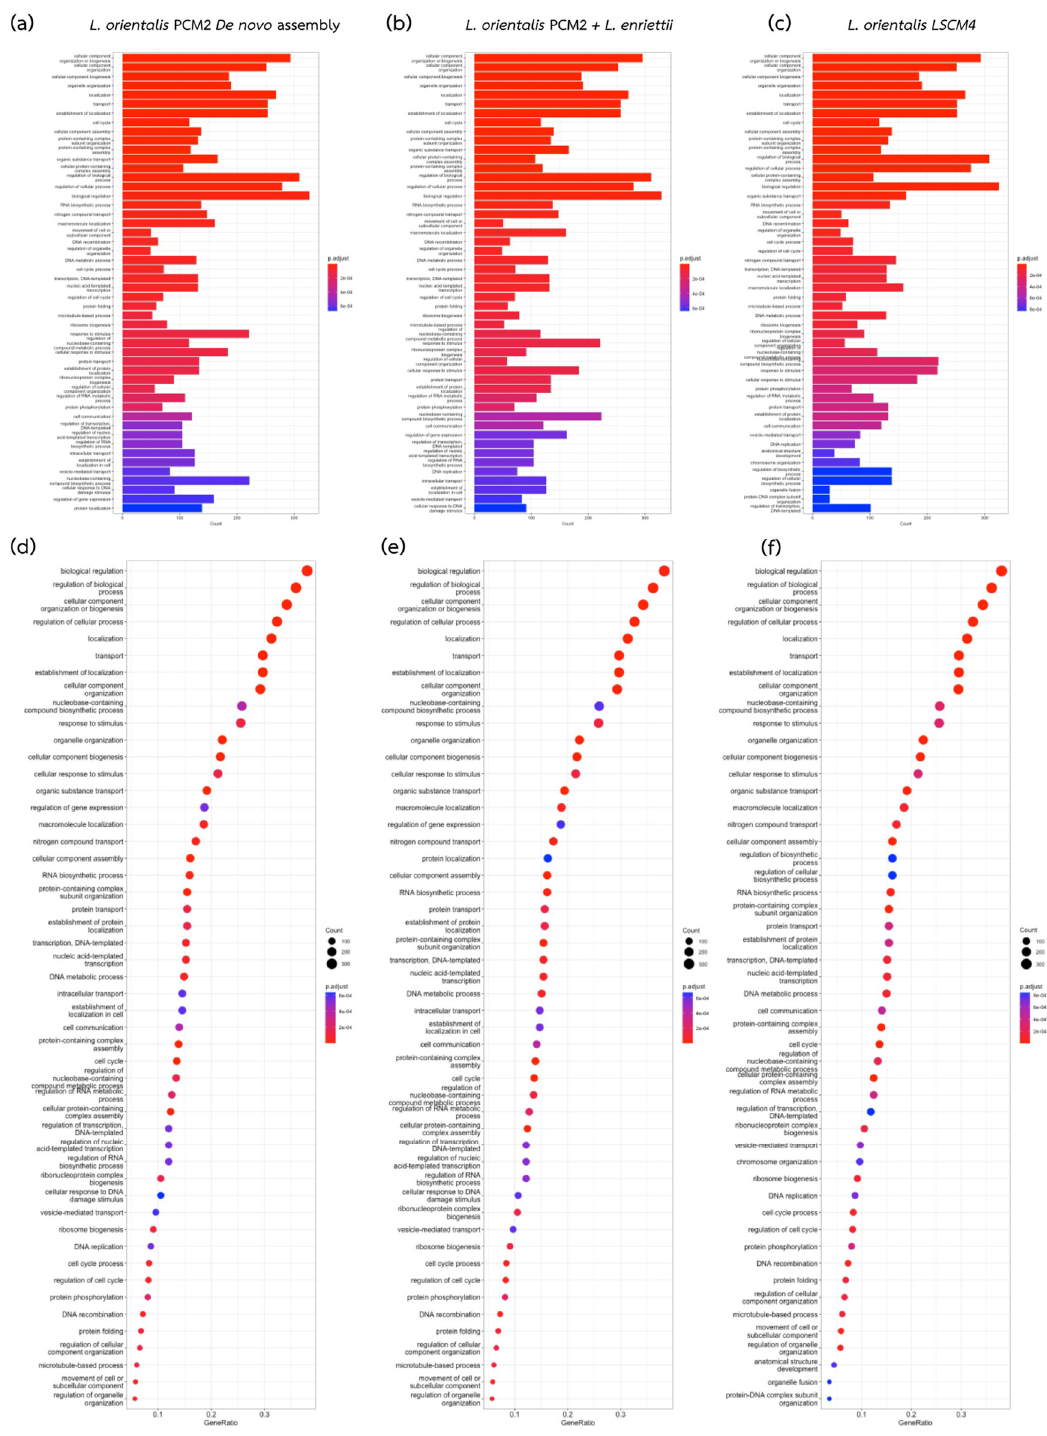
Figure 4. Distribution of the GO-annotated genes of the assembled genome of L. orientalis isolate PCM2 obtained from the single de novo assembly ( a , d ) and the integrated workflow ( b , e ) compared with the reference genome of L. orientalis isolate LSCM4 ( c , f ). ( a – c ) Plots between the GO term cate-gories and gene count with their associated p values. ( d – f ) Plots between the GO terms and the gene ratios (proportion of all assigned GO functions in each genome) with their associated p values. The balloon sizes indicate the gene count.